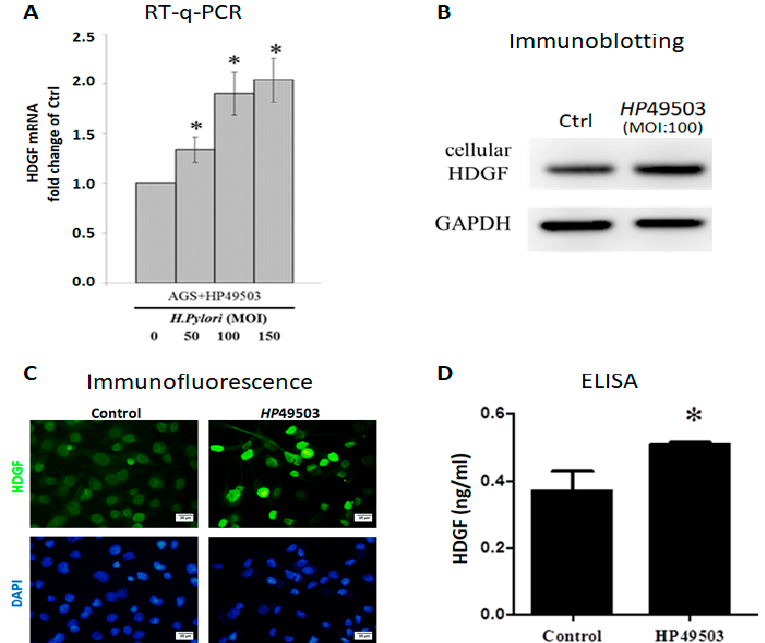
Figure 2. Human AGS cells with HP infection expresses high HDGF level. HDGF mRNA in AGS cells with HP49503 infection for 24 h was analyzed by RT-q-PCR ( A ). HDGF protein from AGS cells infected with HP49503 for 24 h was detected by immunoblotting assay. GAPDH was used as an internal control ( B ). Immunofluorescent staining was used to detect the expression of HDGF in AGS cells with HP49503 infection. Scale bar = 20 µ m. ( C ). Secreted HDGF from AGS cells with HP49503 infection was measured by ELISA assay ( D ). * p < 0.05 versus control (mean ± SD, n = 3). 2.3. HDGF Induces Expression of Myofibroblast and Fibroblast Markers in HBMMSCs To evaluate the influence of HDGF on expression of myofibroblast and fibroblast markers in HBMMSCs, we treated HBMMSCs with various concentration of HDGF (1, 10, 50, 100 ng/mL)